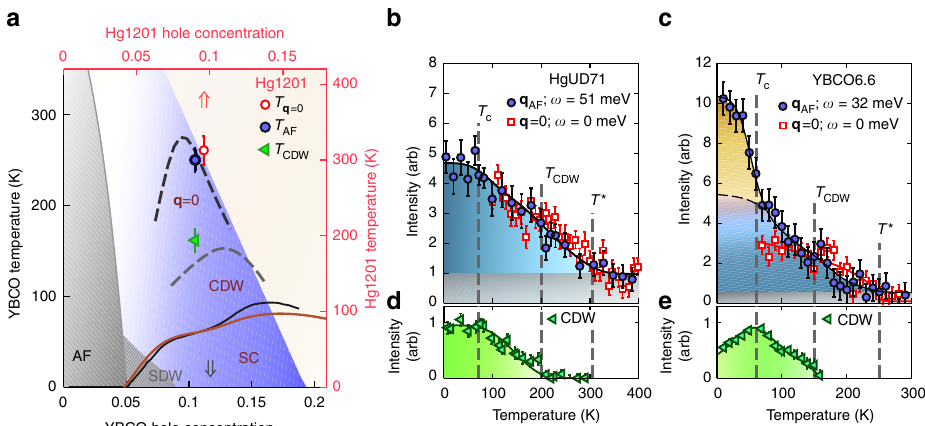
Figure 1 | Phase diagram of Hg1201 and YBCO. ( a ) Phase diagram: Hg1201 (red top-right axes) and YBCO (black bottom-left axes). The axes are adjusted such that the T c ( p ) domes of Hg1201 (red line) and YBCO (black line) approximately line up. The blue region represents the PG regime. The red and grey arrows indicate the doping of HgUD71 ( T c ¼ 71K) and YBCO6.6 ( T c ¼ 61K) highlighted in this work. Dashed black and grey lines represent the temperatures below which q ¼ 0 magnetic order 23,24 and CDW 25–27 correlations are observed in YBCO. The corresponding data for Hg1201 ( T q ¼ 0 , red circle; T CDW , green triangle) for doping levels close to HgUD71 are shown 15–17 . The significant increase in the AF response appears below T AF (blue circle). Grey shaded and hashed areas represent AF and SDW 28 order in YBCO. ( b ) Temperature dependence of inelastic magnetic scattering at q AF and o peak ¼ 51meV and of quasi-elastic (FWHM energy resolution B 1meV) magnetic scattering at q ¼ 0 (from ref. 17) measured on separate Hg1201 samples with similar doping levels ( T c ¼ 71 and 75K, respectively). We determine T q ¼ 0 ¼ 320 ± 20K (ref. 17) and T AF ¼ 300 ± 15K. The q ¼ 0 signal is shifted upward (by one unit) for comparison. Both T q ¼ 0 and T AF are consistent with T * ¼ 305 ± 10K determined from the planar resistivity (deviation from high-temperature linear dependence) 19 . ( c ) Temperature dependence of the q ¼ 0 signal 23 and of the odd-parity resonance ( o r ¼ 32meV) for a twinned YBCO6.6 sample (see Methods for sample details). For b , c , the blue region represents the increase in intensity in the PG state and the grey region is the baseline intensity for T 4 T *. The shaded orange region in c represents the excess scattering below T c because of the resonance mode. ( d , e ) Temperature dependence of short-range CDW order in Hg1201 (ref. 15) and YBCO (ref. 26) at approximately the same respective doping levels as the data in b , c . Vertical error bars in a – c are statistical errors (1